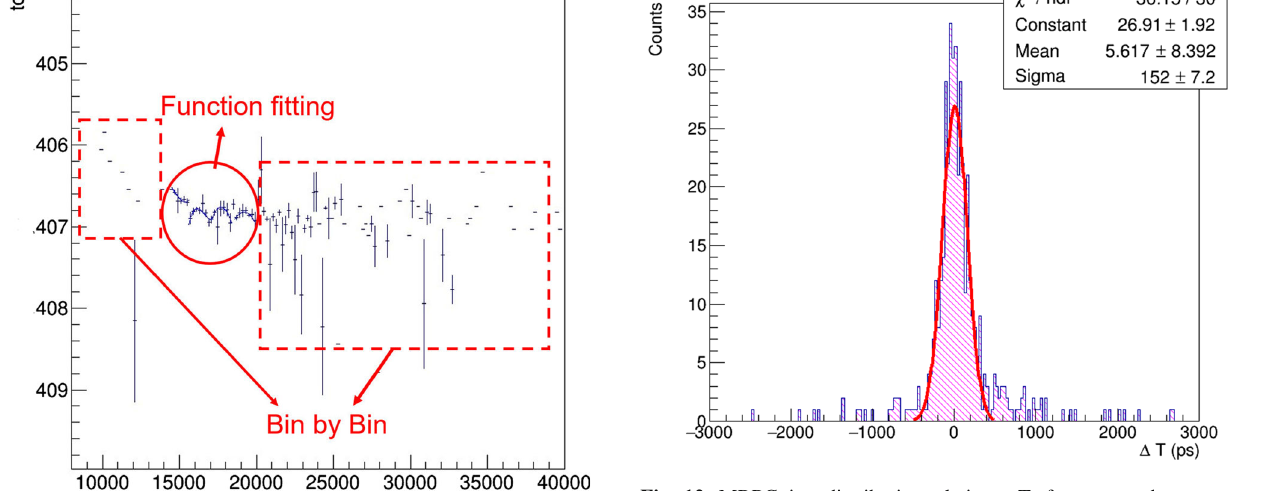
Fig. 12 MRPC time distribution relative to T 0 for a proton beam